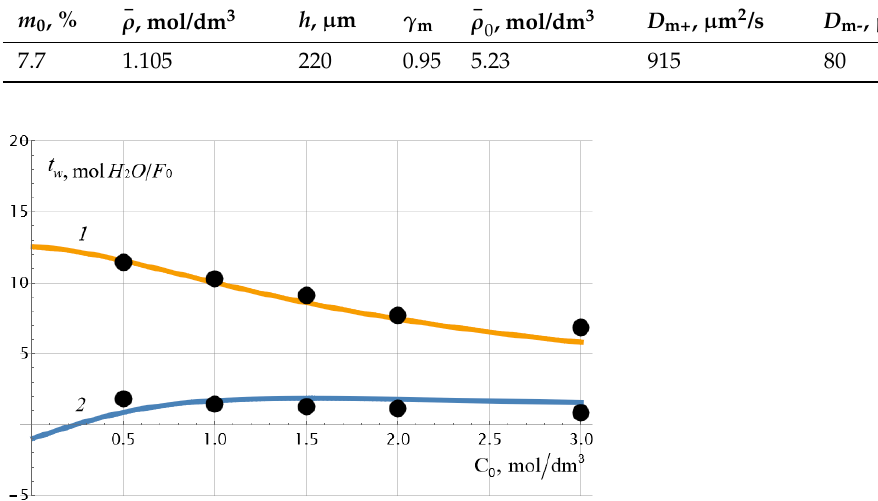
Figure 3. Experimental (symbols) and theoretical values of the electroosmotic (curve 1 ) and osmotic (curve 2 ) numbers of water transport through the MF − 4SC membrane depending on the equilibrium concentration of NaCl aqueous solution in the case of co-directional electroosmotic and osmotic water fluxes.